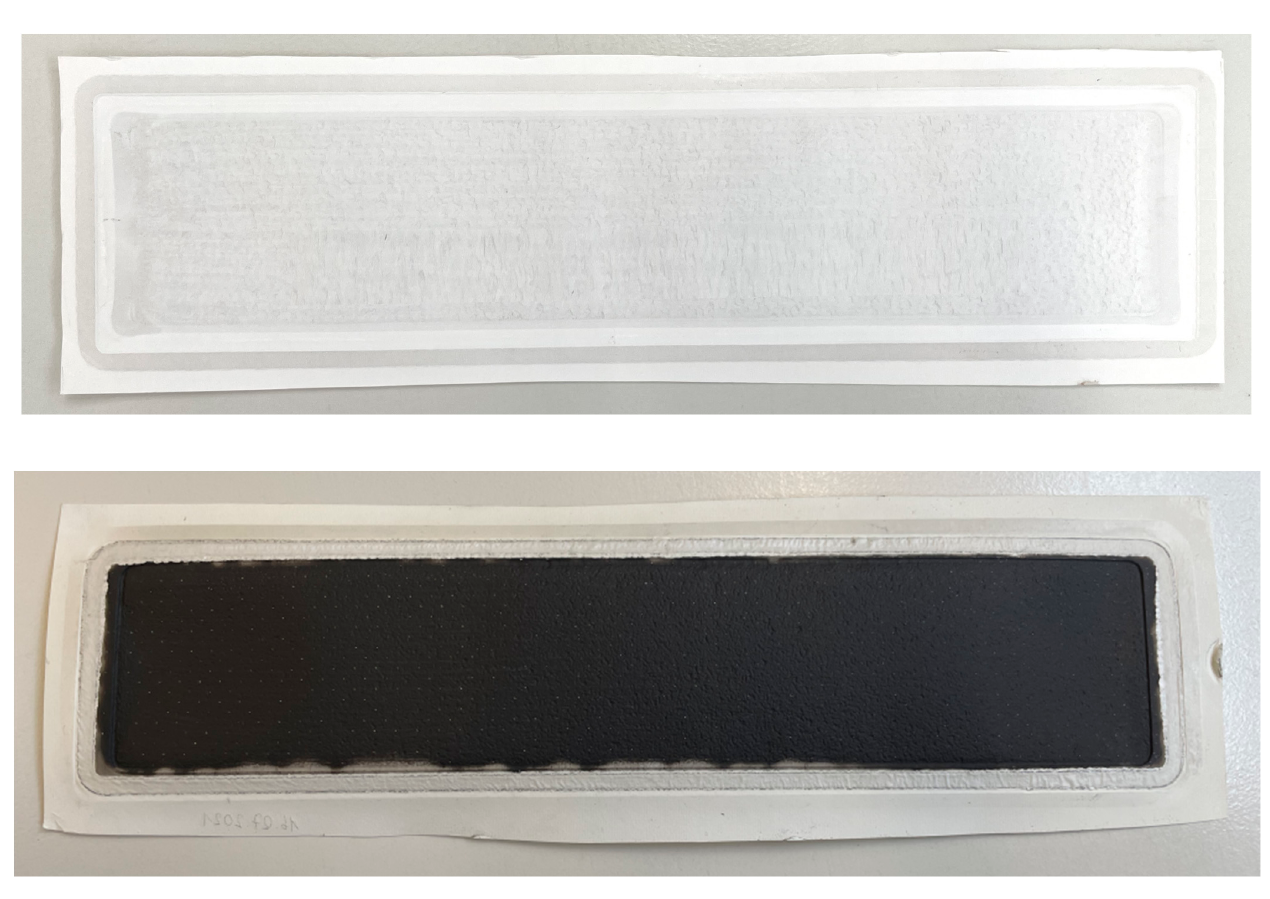
Figure 10. RO membrane before ( above ) and after ( below ) RO experiment. The black fouling layer was observed after 60 days of use.